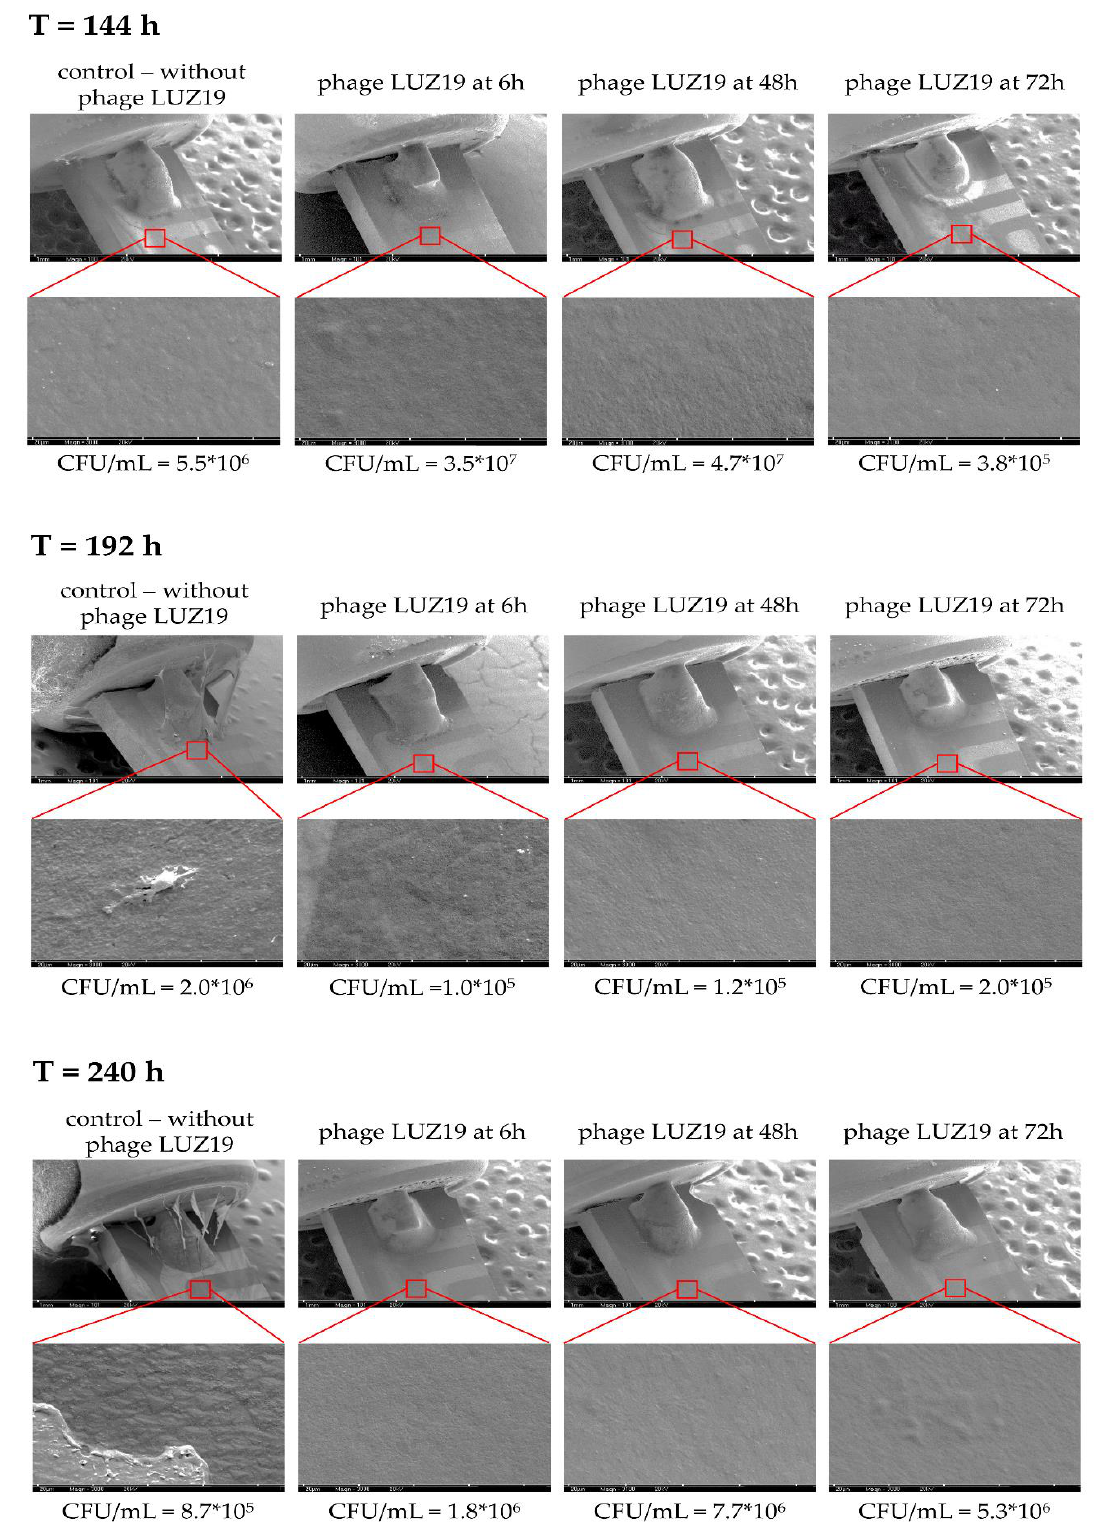
Figure 5. Visualization of QTF sensors at the 144th, 192nd, and 240th hour of untreated and phage LUZ19 treated biofilm at MOI = 1 (from left to right, added at the 6th, 48th and 72nd hour of culture, respectively). The upper panel shows the tuning fork ring at 30× magnification. The bottom panel enlarged 3000× QTF surface. The bottom panel presents the CFU/mL values corresponding to selected time point.